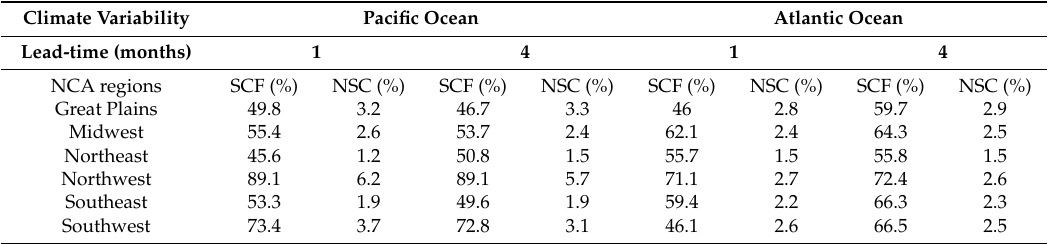
Table 3. SCF and NSC values obtained from SVD analysis for different lead-time